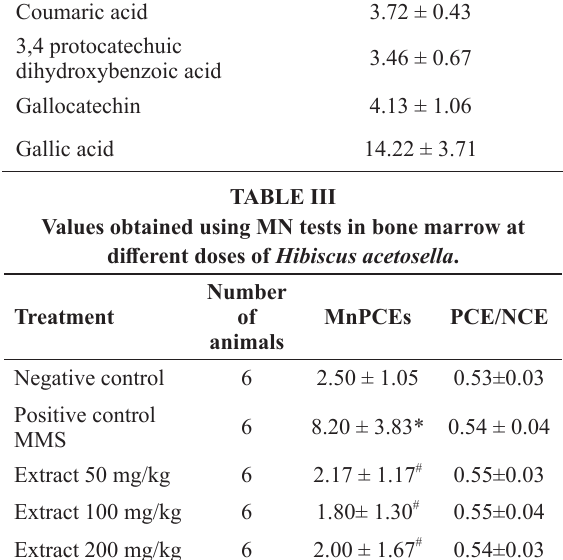
Data are means ± standard deviations (n = 6 animals). A total of 2000 polychromatic erythrocytes (PCEs) were analyzed per animal. * Significant difference compared with the negative control, p < 0.05 (ANOVA, Tukey test). # Significant difference compared with the positive control MMS, p < 0.05 (ANOVA, Tukey